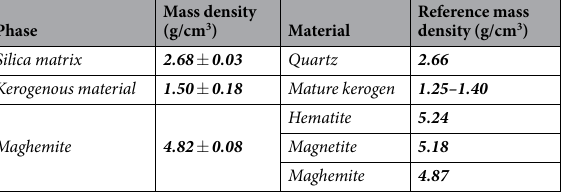
Table 1. Phases of compounds identified in the Mink Mountain filaments on the basis of their calculated mass density from obtained refractive indices, and comparison with reference values 26,27,35,50